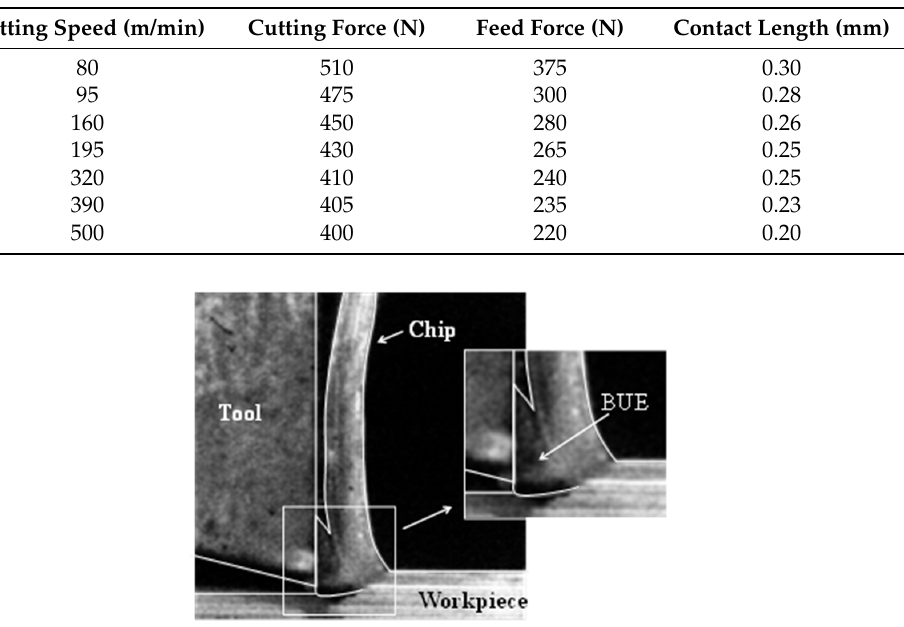
Figure 4. BUE (built-up edge) formation for cutting speed = 60 m/min, feed = 0.1 mm and rake angle = 0°.